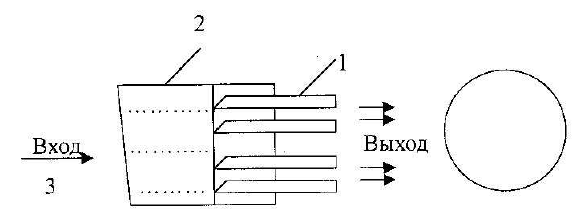
Figure 1: Model of a porous